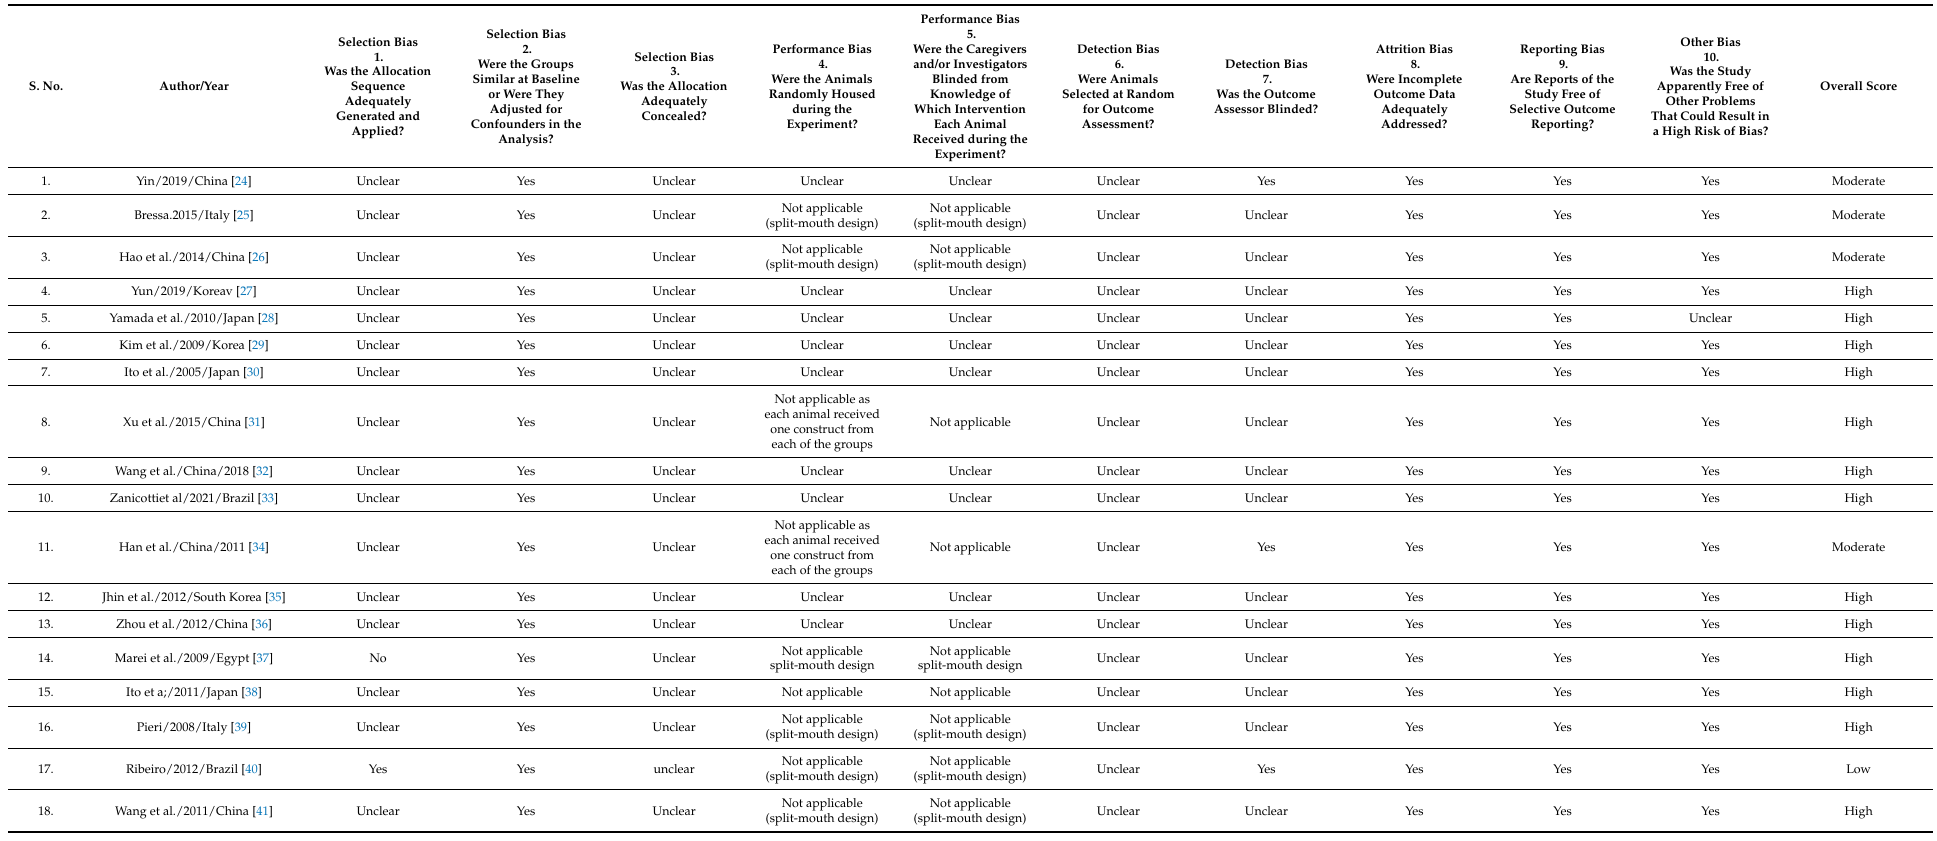
Table 2. Summary of the ROB analysis of the included